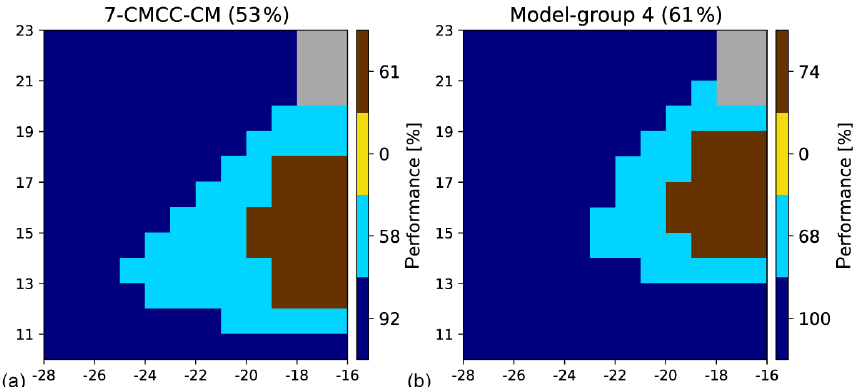
Figure 9. Same as Fig. 7 but for the individual model CMCC-CM (model 7) (a) and model group 4 (b) .